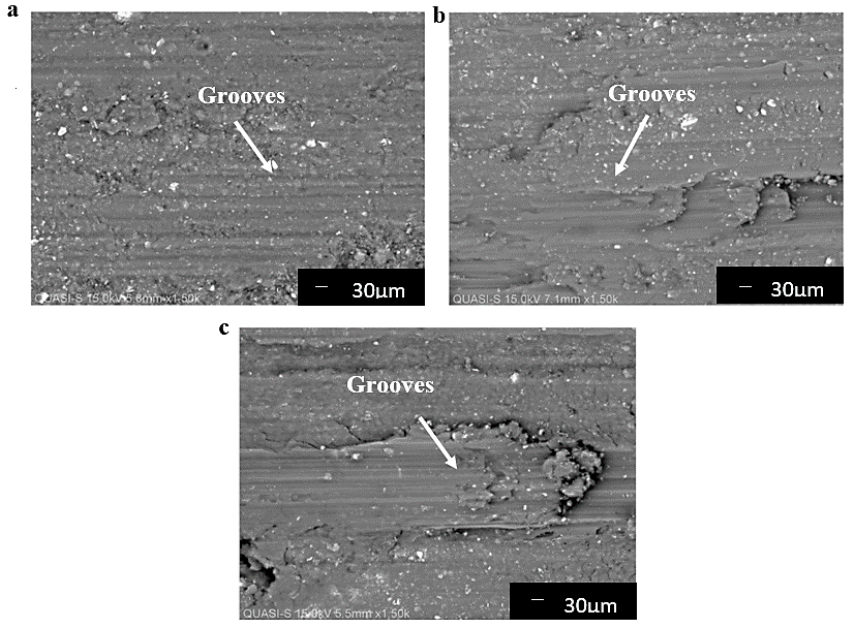
Figure 9. SEM image of HPCS Al coatings at an applied loads of ( a ) 2 N; ( b ) 3 N; and ( c ) 5 N.